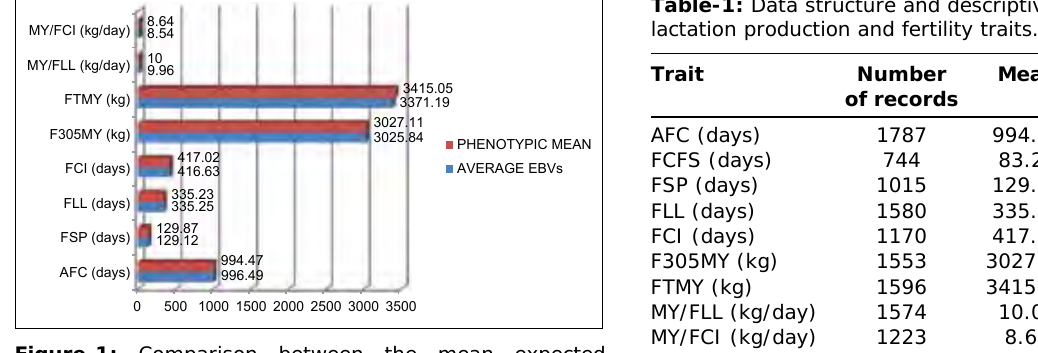
Figure-1: Comparison between the mean expected breeding values and the average phenotypic values for production and fertility traits.